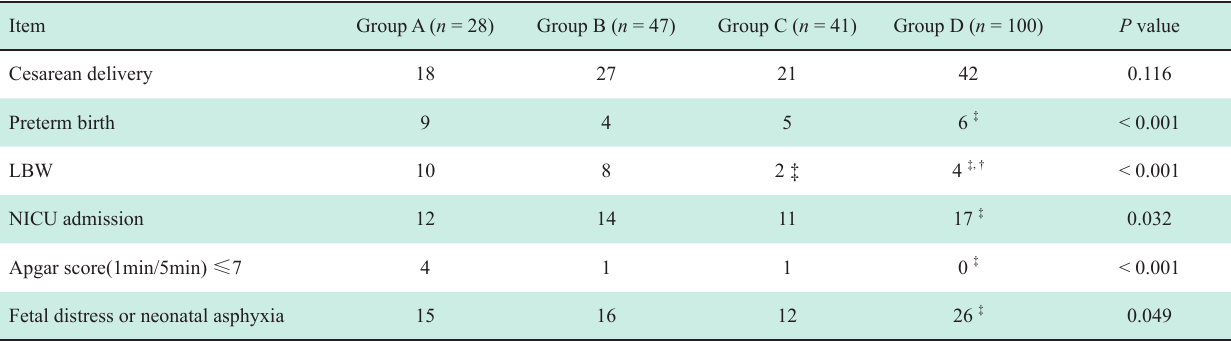
Table 7 Adverse outcomes of live births of four